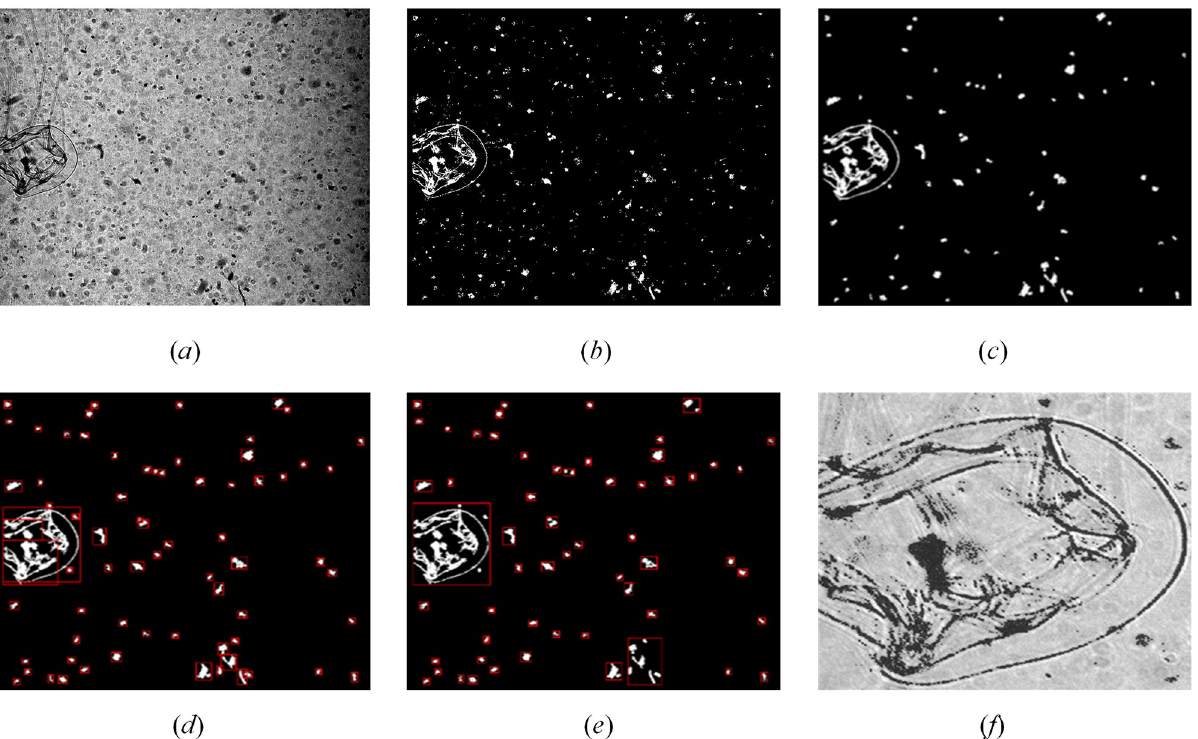
Fig 6. Effects of ROI enhancement with different steps. ( a ) Original plankton image, the contrast of which is adjusted only for illustration purpose due to the heavy darkness of original image, and the procedure directly use the original image; ( b ) The effect of binarization with Sauvola’s method; ( c ) The effect of denoising and edge roughening; ( d ) Extraction of ROIs based on connected domain; ( e ) Extraction of ROIs with rectangular merging method based on RPN [45]; ( f ) Final enhanced ROI after background suppression, δ =